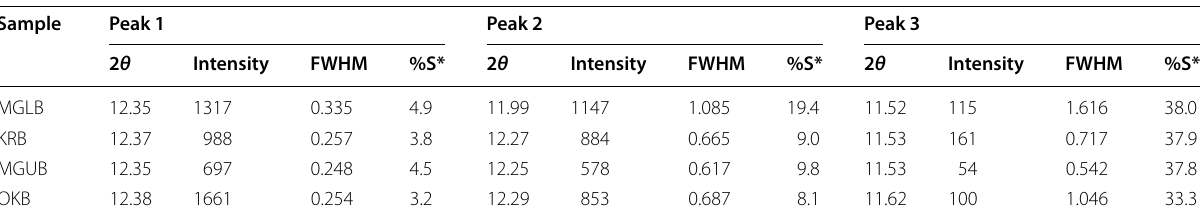
Table 2 Results of peak decomposition for the 7.1 Å band